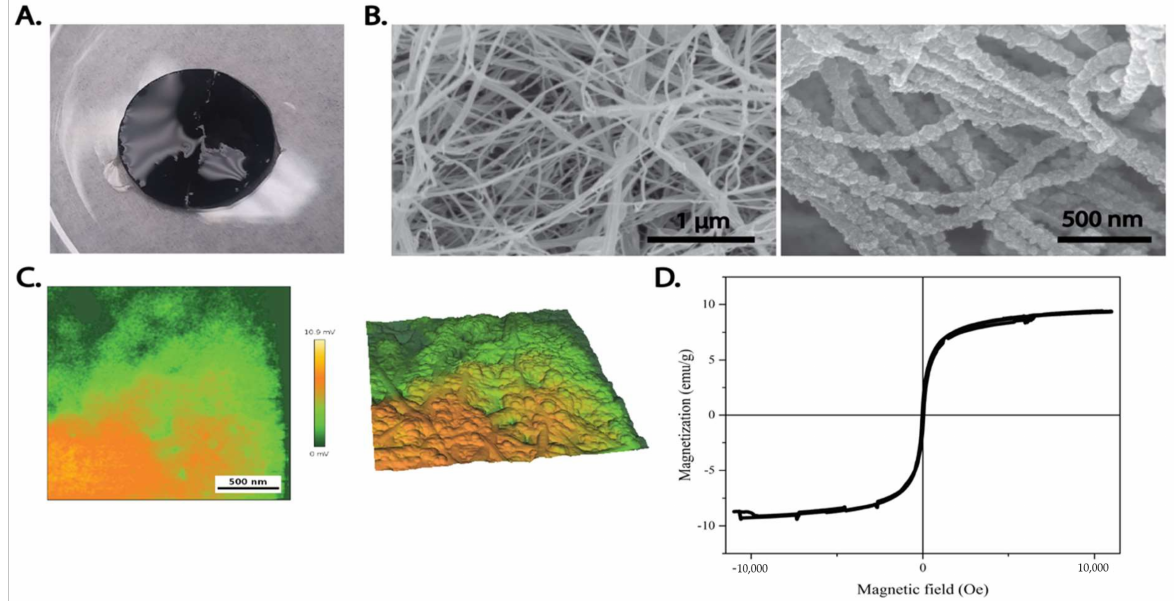
Figure 5. Magnetic BC. ( A ) Macroscopic appearance of a magnetic BC hydrogel loaded with ferro- magnetic nanoparticles. SEM images of ( B ) Pristine (left) and ( C ) magnetite-functionalized BC (right). ( D ) Magnetization saturation curve for 100 mM MBC shows that composite is superparamagnetic and has a maximum magnetic saturation of 10 emu/g. Reproduced with permission from [18] (Copyright © 2022, Journal of Visualized Experiments), [21] (Copyright © 2022,